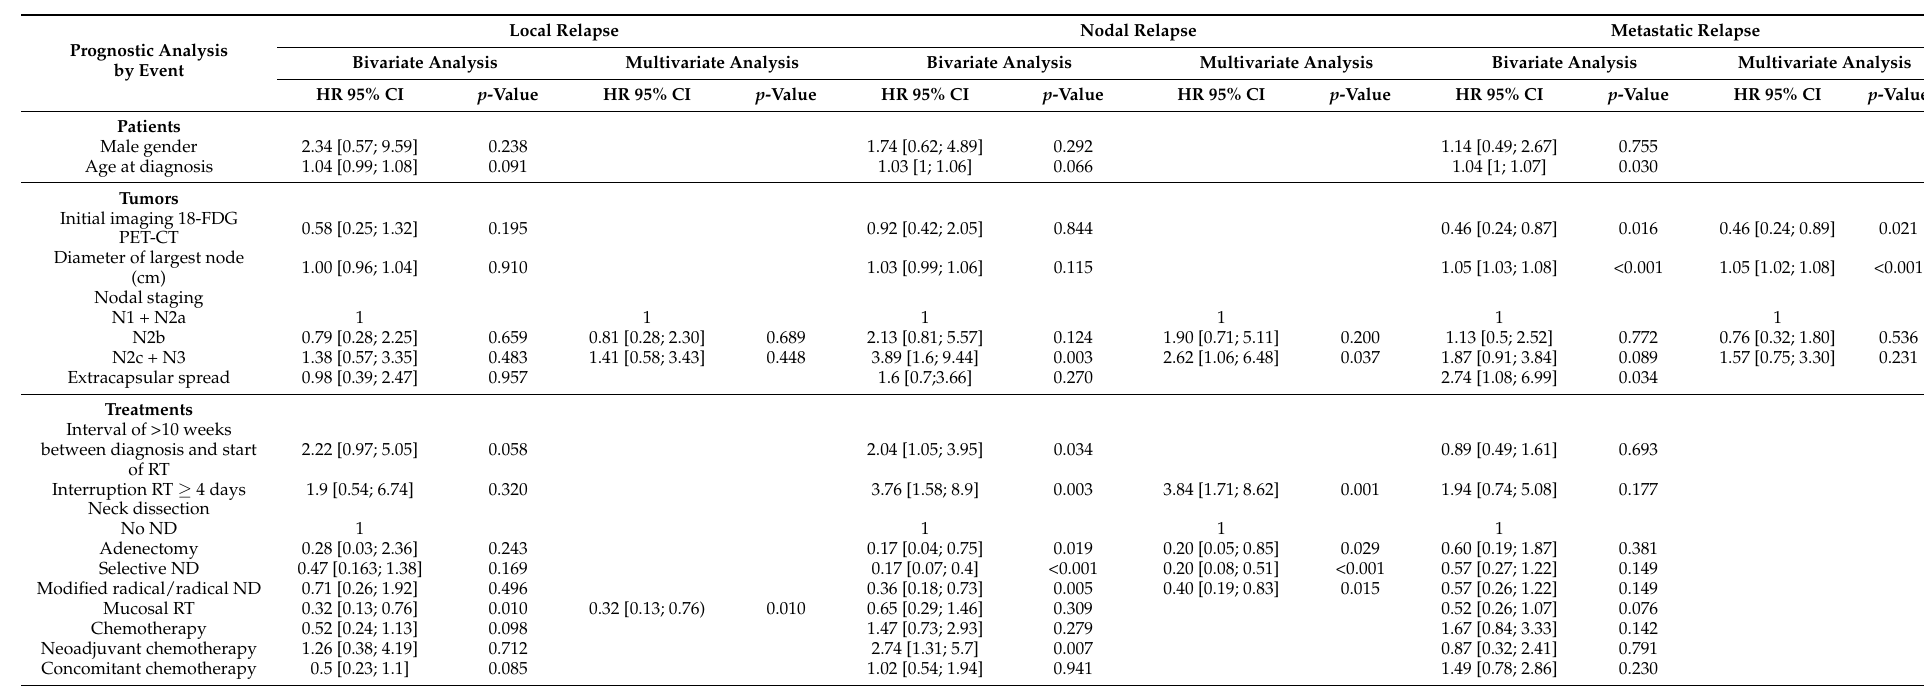
Table 2. Prognostic factors of local (mucosal), nodal and metastatic relapse of HNCUP in bivariate and multivariate analysis, using the Fine and Gray model for competitive factors. Local Relapse Nodal Relapse Metastatic Relapse Prognostic Analysis Bivariate Analysis Multivariate Analysis Bivariate Analysis Multivariate Analysis Bivariate Analysis Multivariate by Event